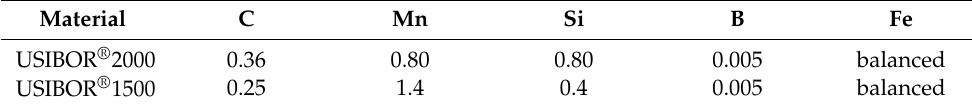
Table 1. Chemical composition for USIBOR ® 2000 and USIBOR ® 1500, wt-%. Material